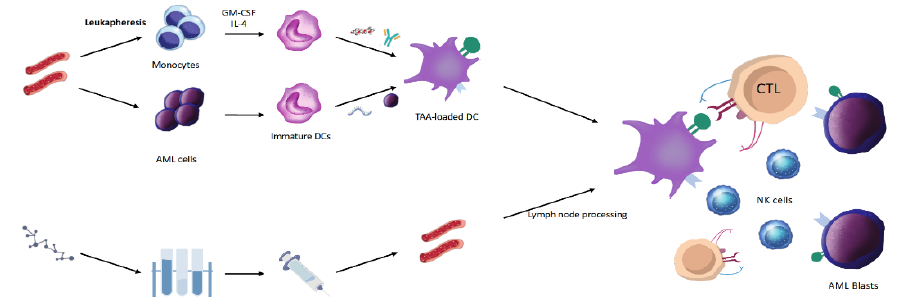
Figure 1. Main mechanisms for vaccine-based immunotherapy production and function in acute myeloid leukemia (AML). Top left: CD14+ monocytes or blast cells are collected from peripheral blood and differentiated into immature dendritic cells (DCs) in culture with IL-4 and GM-CSF. Mature DCs loaded with tumor-associated antigens (TAA) are then obtained by specific procedures (e.g., mRNA electroporation, pulsing with apoptotic AML cells or their lysates, or directly with peptides). Mature TAA-loaded DCs are reinfused in patients. Bottom left: peptide vaccine production. Preselected peptides (e.g., WT1, RHAMM) are prepared in a laboratory as modified constructs or integrated with other molecules and reinfused in patients. In lymph nodes, they are internalized, processed, and exposed by antigen-presenting cells (APC), particularly Ds. On the right, the terminal stage of vaccine therapy is represented, in which DCs induce the activation of immune effectors CD8+ cytotoxic lymphocytes (CTLs) and NK-cells, which attack, in turn, AML blasts.